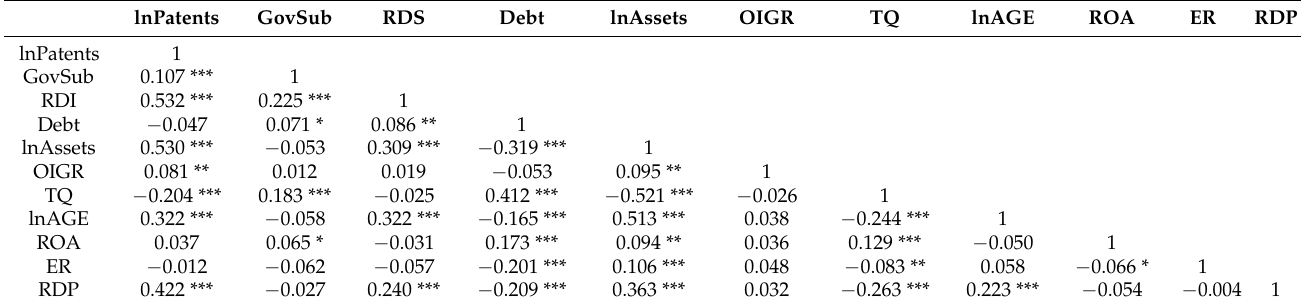
Table 3. Pearson’s correlation coefficient.